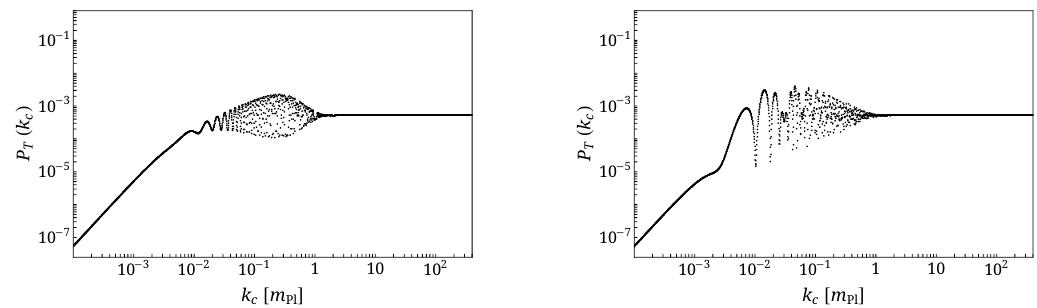
Figure 13. ( First panel ) Spectrum of reference. ( Second panel ) Spectrum with a wider bounce described by σ = 100 and shifted to µ = − 500, the other bounce parameters remaining unchanged with respect to the reference case.